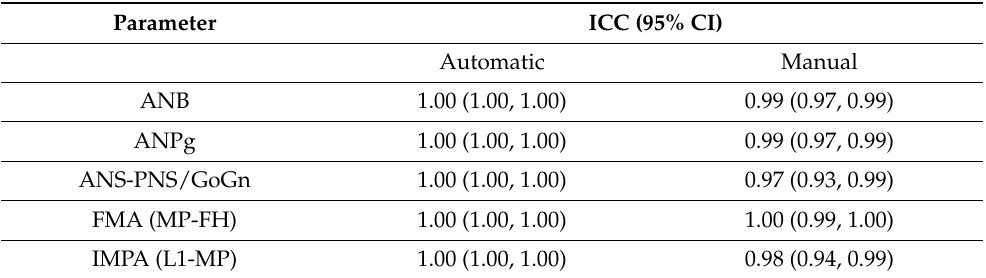
Table 1. Intraclass correlation coefficient (ICC) and 95% confidence interval (CI) for intra-method agreement.